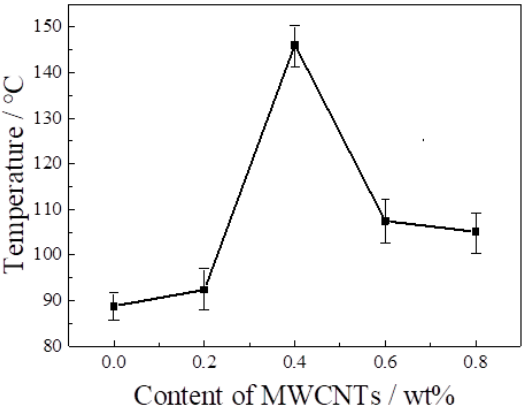
Figure 10. The T g of epoxy nanocomposites with the content of various PABA-modified MWCNTs.